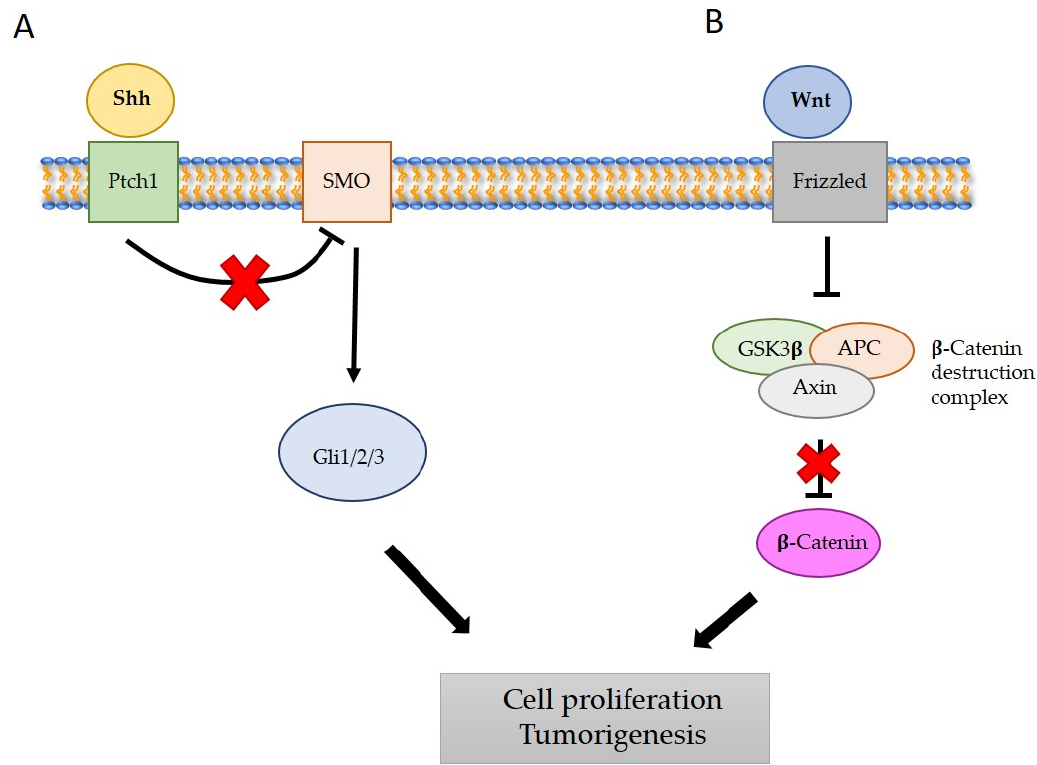
Figure 2. The Sonic Hedgehog (SHH)/Patched (PTCH1) and WNT signaling pathways. ( A ) The SHH ligand inactivates the PTCH1 receptor allowing Smoothened (SMO) to become active. Red cross represents the release of the inhibition exerted by PTCH1 on SMO when SHH is present. The SMO activates the GLI proteins, a family of transcription factors that turn on the expression of different target genes, giving raise to cell proliferation and tumorigenesis (activation of the pathway represented with black arrows). ( B ) The binding of WNT to the Frizzled receptor activates a cascade of downstream events, resulting in the inactivation of the β -catenin destruction complex. The red cross represent the release of the inhibition exerted by the β -catenin destruction complex on β -catenin. In consequence, β -catenin activates and promotes the transcription of genes that promote cell proliferation and tumorigenesis (represented with black arrows). Adapted from [21,23].